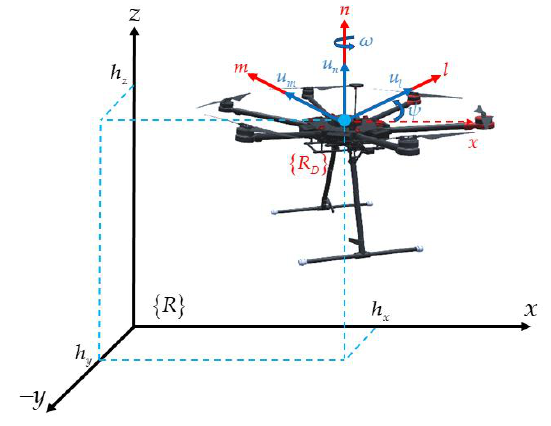
Figure 3. Diagram of the aerial robot.